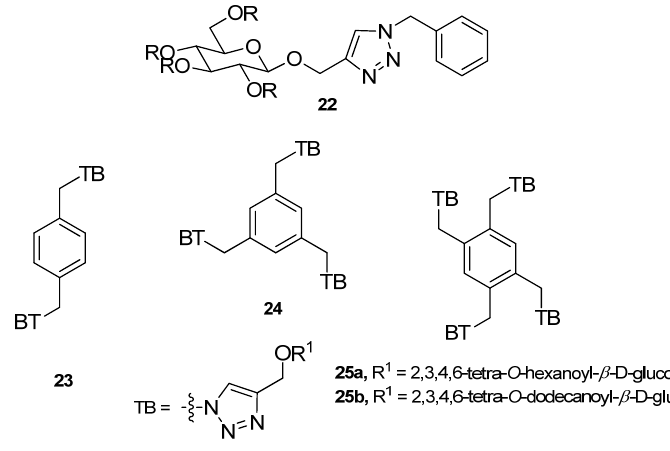
Figure 16. Triazole appended lactobionic acid amide based glycolipid.